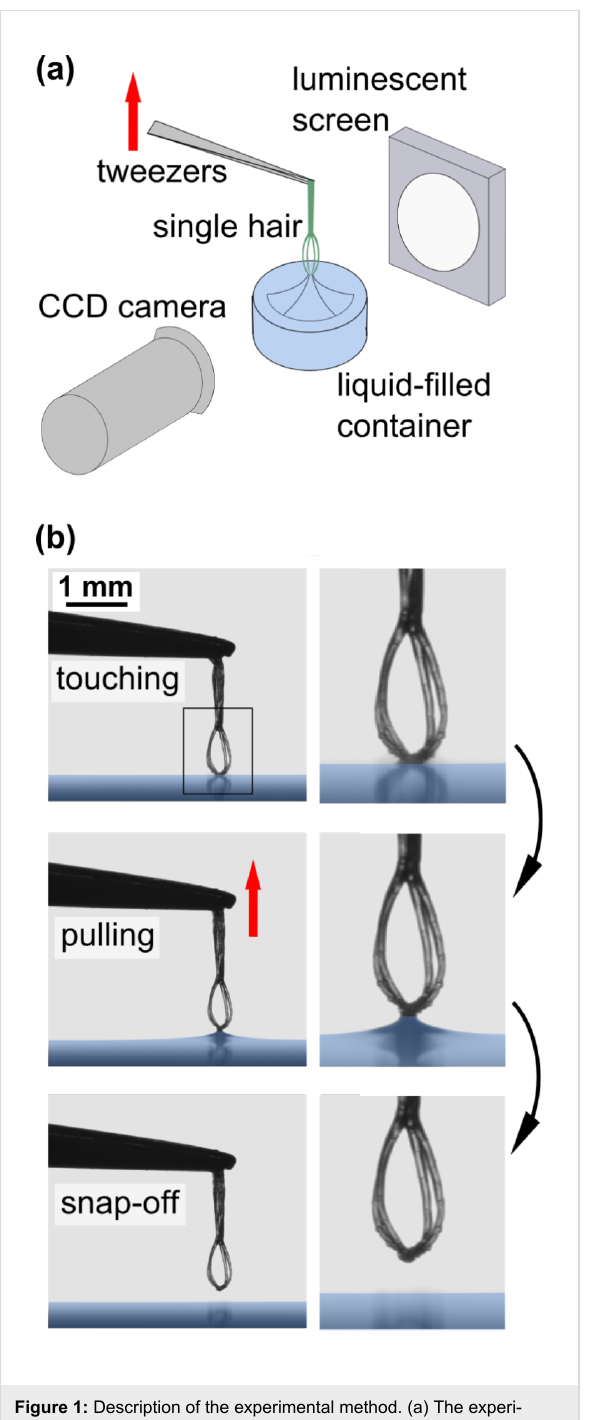
Figure 1: Description of the experimental method. (a) The experi- mental setup: A small elastic entity, in this case a hair (trichome) of Salvinia molesta , is placed between a luminescent screen and a CCD camera above a container filled with liquid. Using reverse action tweezers fixed on a stepper motor, the trichome is vertically descended onto the surface of the liquid (water). (b) After touching the liquid, the subsequent removal of the hair results in the formation of a meniscus. As the tip is pulled upwards, the meniscus eventually snaps off. The geometry of the mensicus immediately before snap-off (i.e., rupture of the meniscus) and the deformation of the trichome are recorded and evaluated.